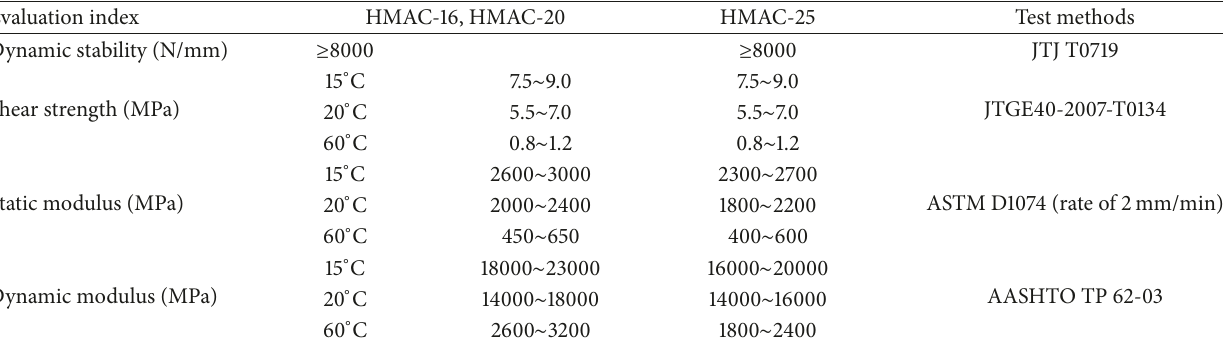
Table 10: Comprehensive evaluating system of HMAC